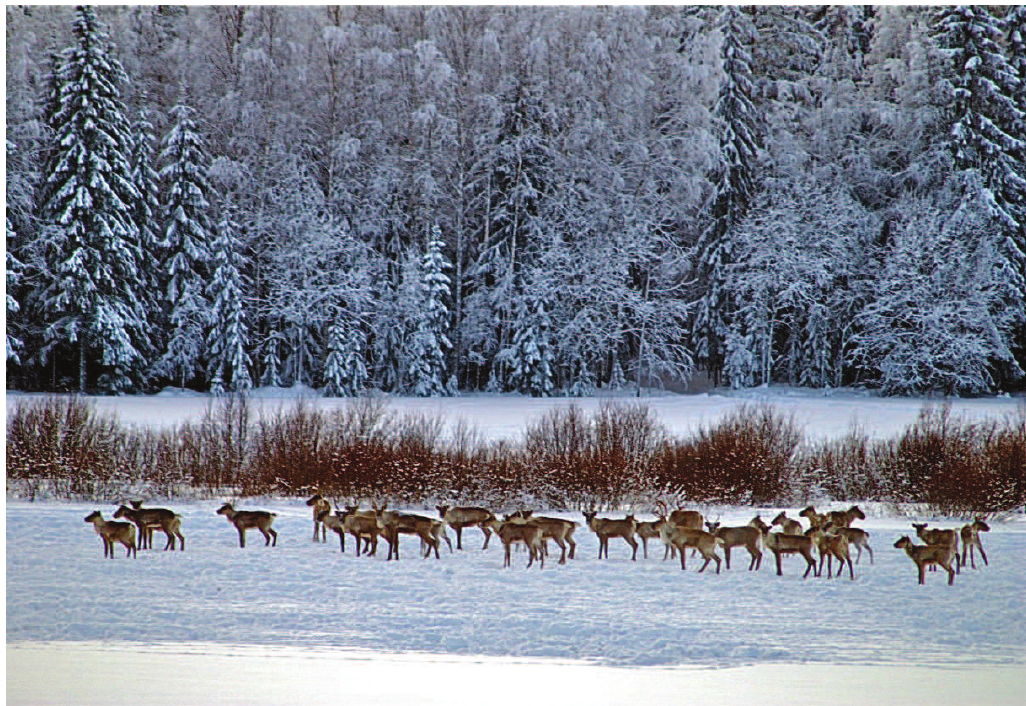
Fig. 2. The alert distance (AD) of a wild forest reindeer group in the Suomenselkä area, in February 2010. The reindeer group displayed an increased alert response by grouping together or by individuals urinating with one hind leg extended outward at an exaggerated angle, while staring at the directly approaching observer. Photo Mauri